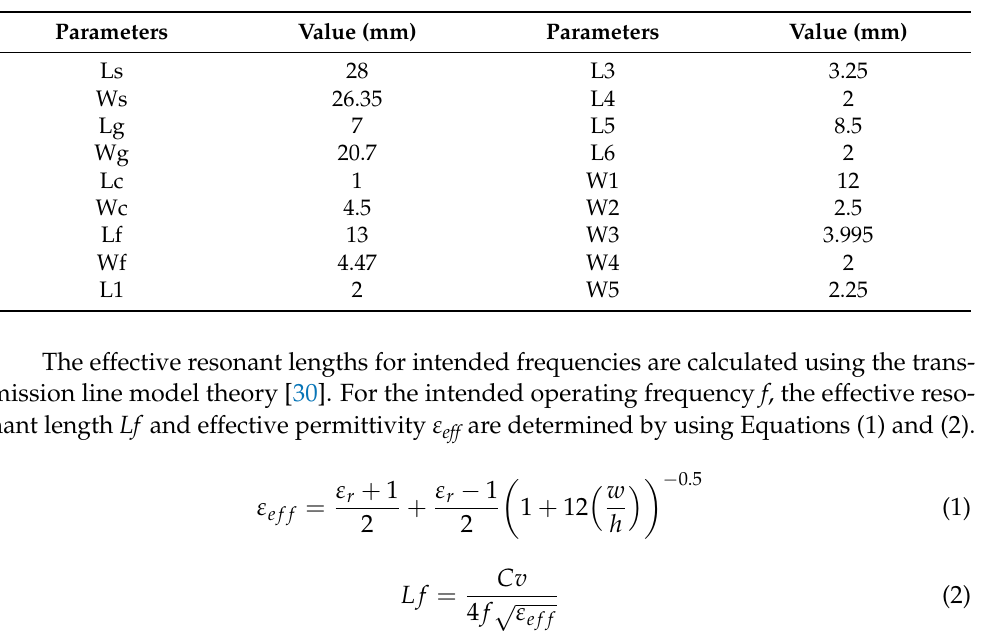
Figure 2. Prototype antenna structure: top and bottom view. Table 1. The suggested optimum antenna parameters.